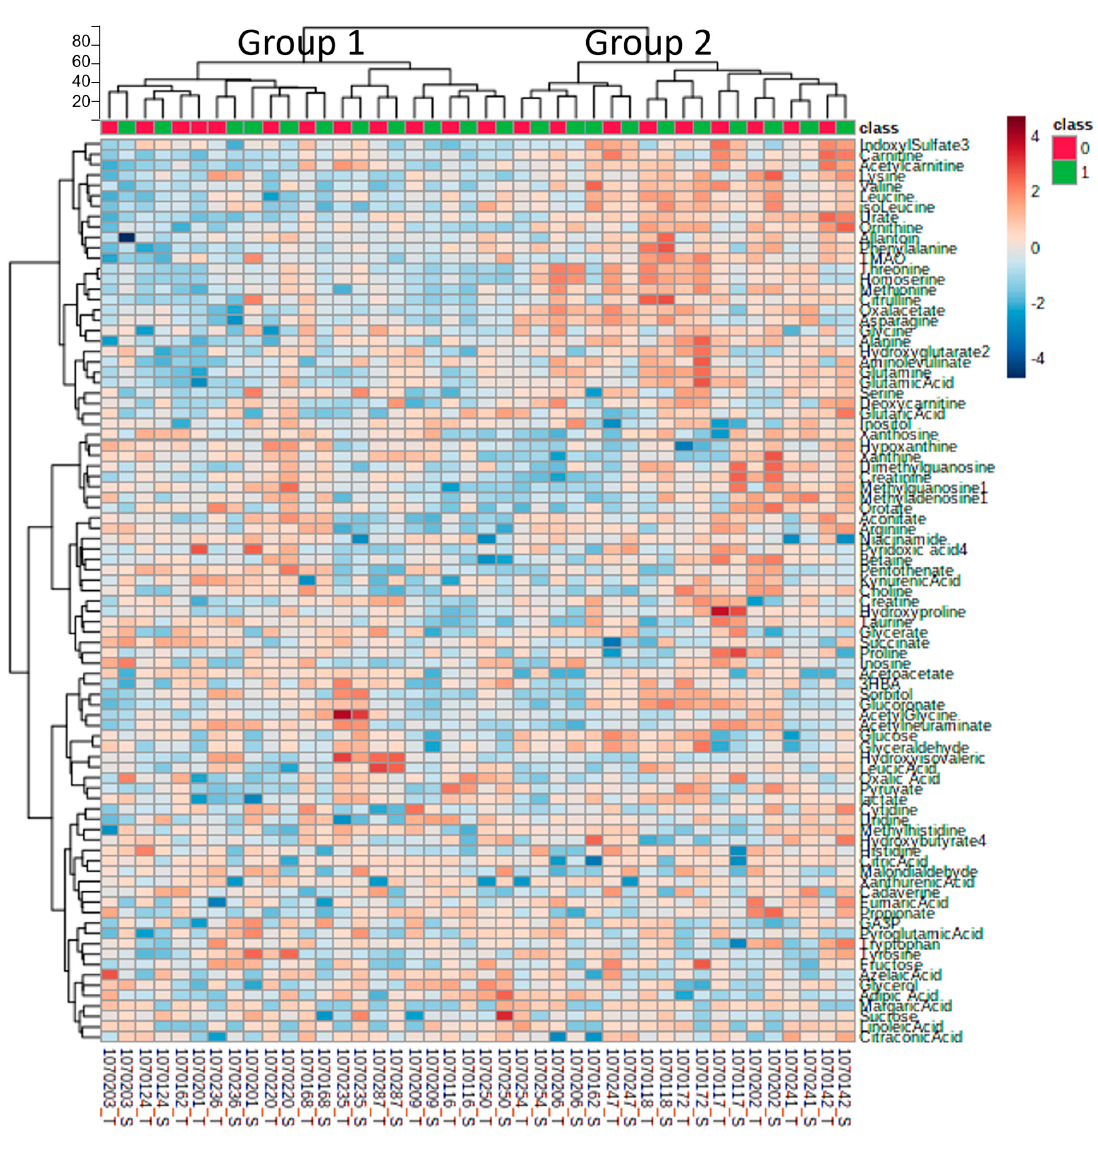
Figure 2. ( a ) PCA plot of the metabolites. Pink circles indicate saline; green circles indicate TG infusion. Graph was generated using MetaboAnalyst. ( b ) HCA heat map generated by Metaboanalyst (using Euclidean clustering, Ward method). Class 0 is saline; class 1 is TG infusion. Each colored cell on the map corresponds to a normalized concentration value, with samples in rows and compounds in columns. Red and blue colors indicate positive and negative correlations, respectively. Group 2 was more likely to be male and have more cognitive impairment. Table 2. Metabolite differences (conc in uM) between treatment groups. p value from paired T test.